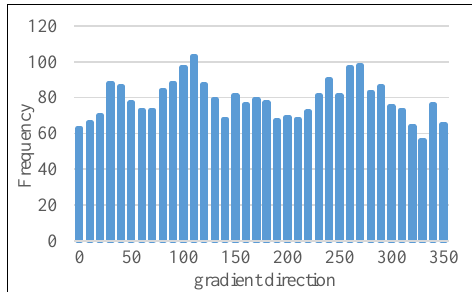
Figure 4. Histogram of gradient directions from clear images